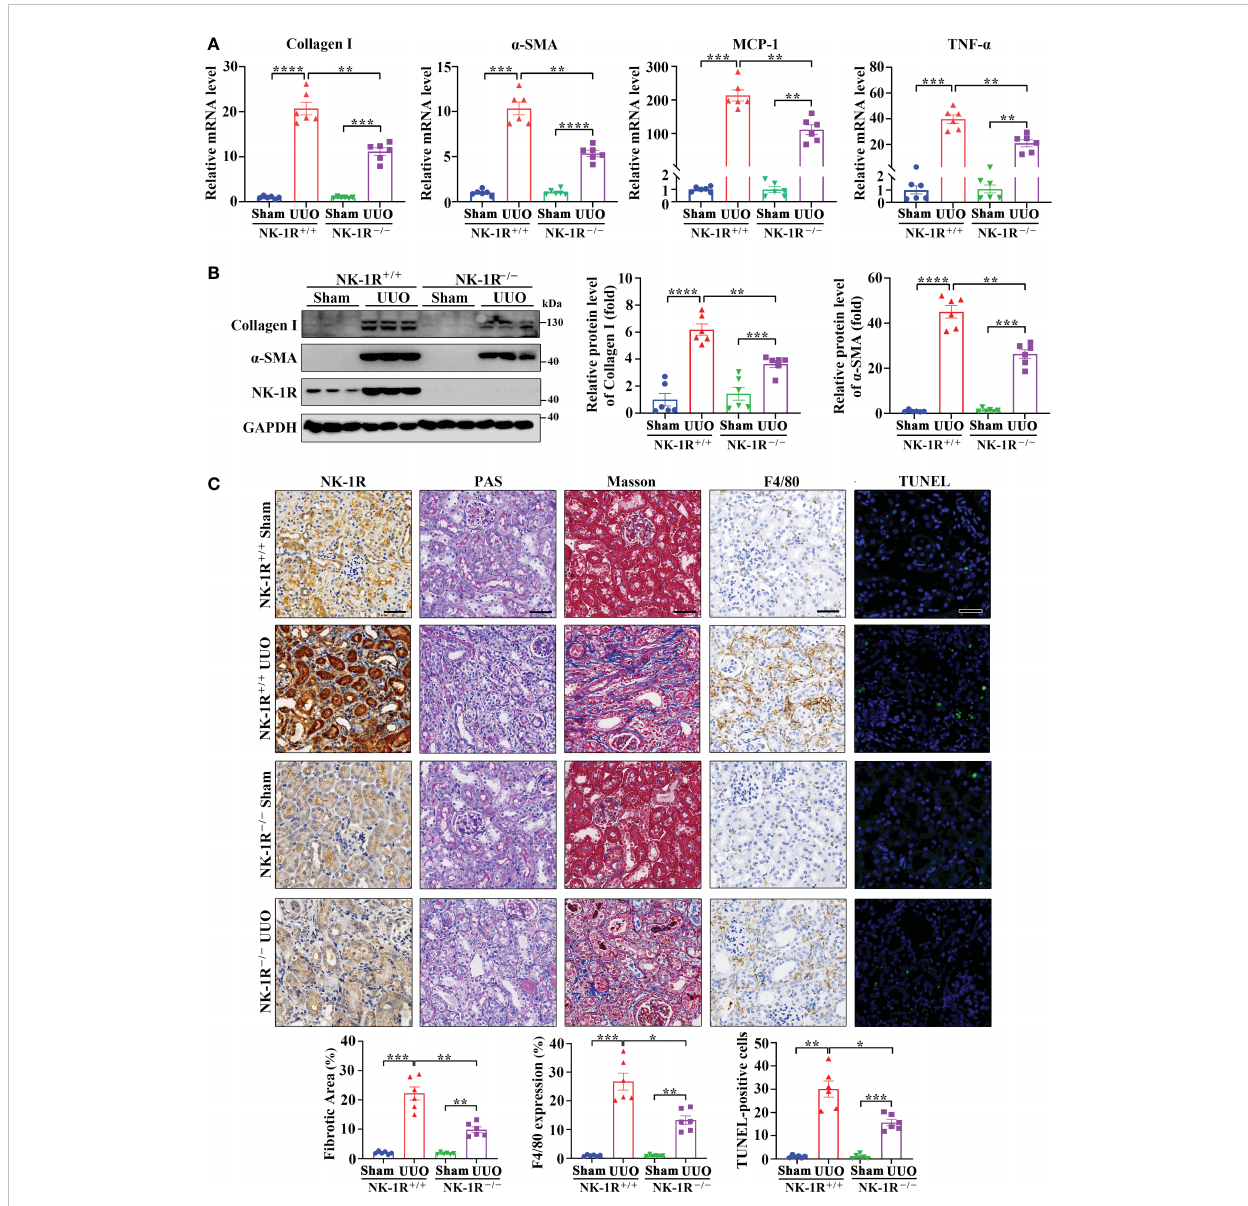
FIGURE 3 Genetic deletion of NK-1R alleviated UUO-induced renal fi brosis, in fl ammation, and apoptosis. (A, B) RT-qPCR (A) and Western blotting (B) displayed the reduced mRNA (A) and protein (B) levels of Collagen I, a -SMA, MCP-1, and TNF- a in renal cortical tissues of NK-1R knockout (NK-1R -/- ) UUO mice, compared with NK-1R wildtype (NK-1R +/+ ) UUO mice. (C) Immunochemistry staining of NK-1R and F4/80, PAS, Masson ’ s trichrome, and TUNEL analysis showed that the deletion of NK-1R attenuated UUO-induced renal fi brosis, in fi ltration of F4/80-positive in fl ammatory cells, and apoptosis. For (A – C) , mouse kidneys were excised on day 14 after UUO. Analysis of TUNEL-positive cells was counted by fl uorescence microscopy in ten randomly selected high-power fi elds per kidney section. Scale bar, 50 µm. Data are shown as mean ± SEM from groups of six mice. * p <